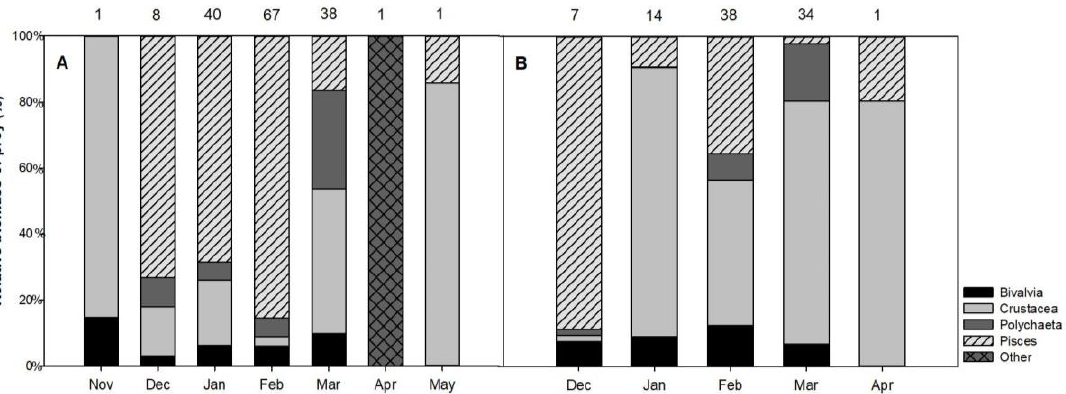
Figure 3. Long-tailed duck’s prey composition according to wet weight biomass (%) during the win- tering period in ( A ) hard-bottom and ( B ) soft-bottom habitats. Upper numbers indicate sample sizes. Ivlev’s selectivity index calculated for hard-bottom habitats demonstrated the highest values for H. diversicolor (r i = 0.44, p i = 0.001, E = 0.99) and bivalves (r i = 0.03, p i =